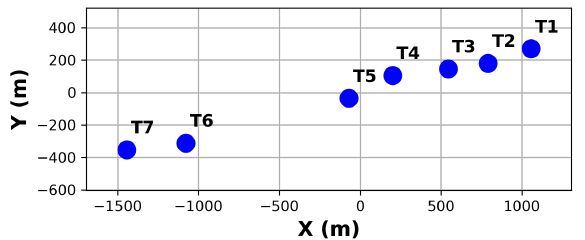
Figure 1. The layout of the test case wind